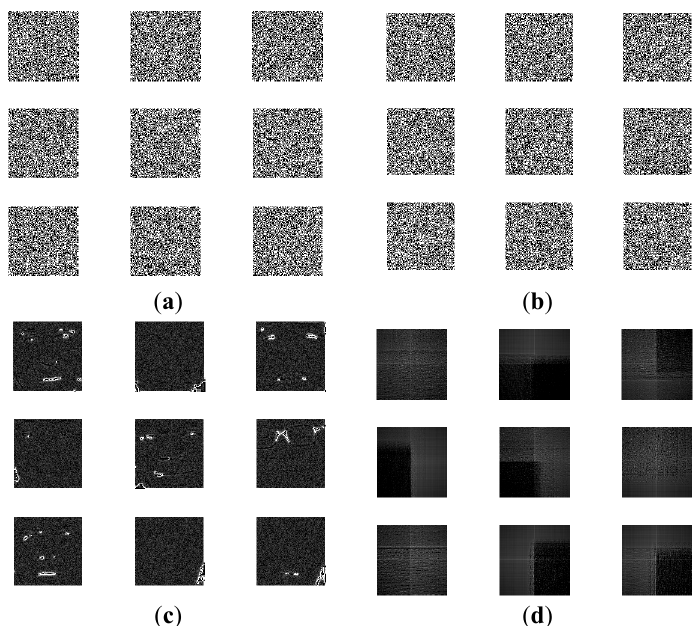
Figure 22. Encrypted versions of biometric faces in Figure 14 (i.e., from LFW dataset) for ( a ) CFR1 ( b ) CFR2, ( c ) homomorphic transform followed by salting and ( d ) homomorphic transform followed by random kernel convolution.